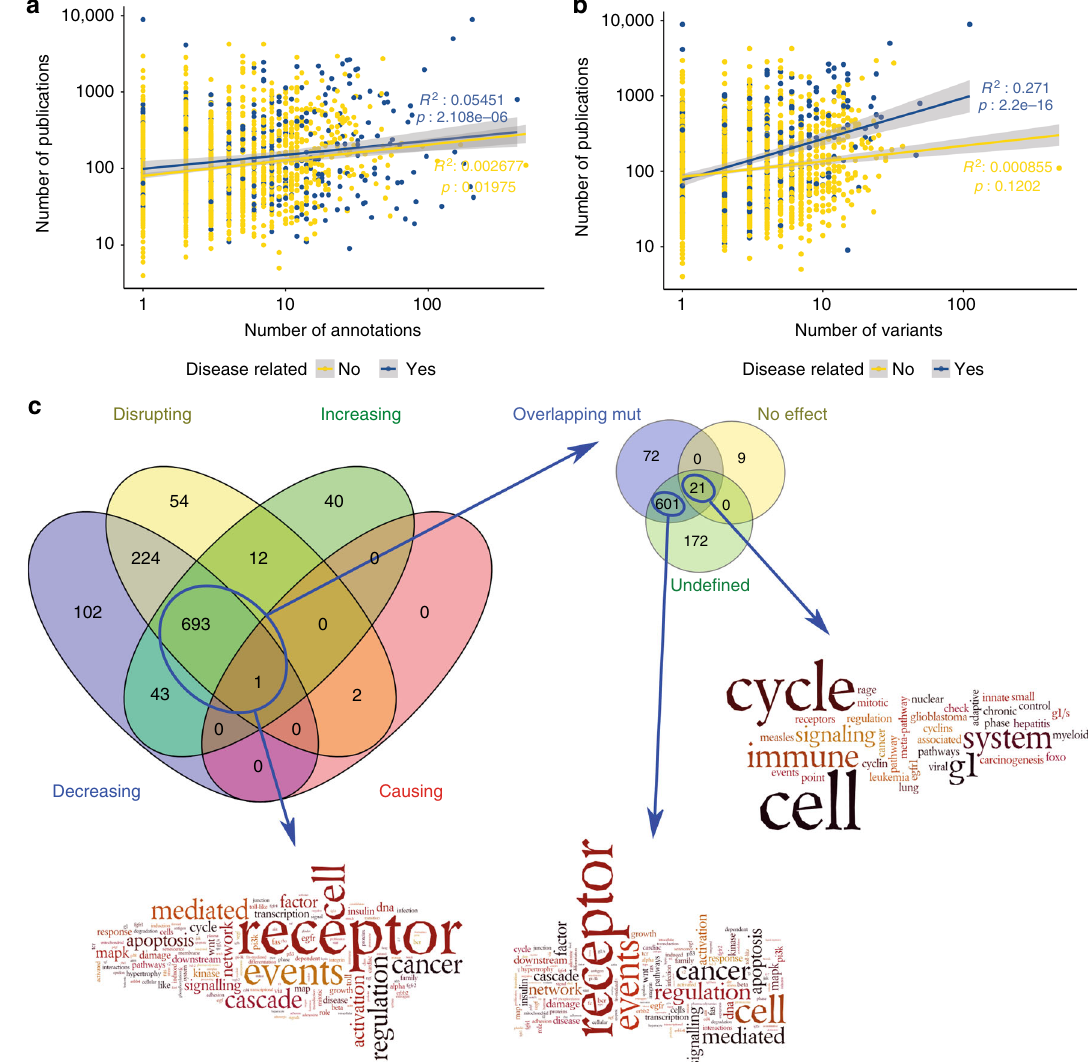
Fig. 6 Literature biases in IMEx mutations data set. a , b : Scatter plot of number of publications (in a logarithmic scale) in which a protein is reported vs a the number of annotations and b the number of variants reported in the IMEx mutations data set. Disease-related annotations are highlighted in blue, unrelated to disease in yellow. Regression lines are coloured accordingly. Correlation coef fi cients and p-values for the linear model fi t are indicated. 95% Con fi dence Interval (CI) is shown as greyed areas over the regression lines; c Overlap of signi fi cantly enriched pathways ( q < 0.01) across different sets of proteins and word enrichment analysis (using Wordle on enriched pathway names) for the overlapping set (any mutational effect), the set of proteins annotated with no effect and the remaining proteins in IMEx (non-mutated). In ‘ No effect ’ word enrichment analysis, the words ‘ pathway ’ and ‘ action ’ have been removed to make remaining words more visible (original word cloud available as Supplementary Figure 6a), while in ‘ Overlapping mut ’ word cloud the words ‘ pathway ’ and ‘ signalling ’ have been removed (original word cloud available as Supplementary Figure 6b). The analysis in this fi gure was performed considering human proteins only. Source data for Fig. 6a and 6b are provided as a Source Data fi le, source data for Fig. 6c is available as